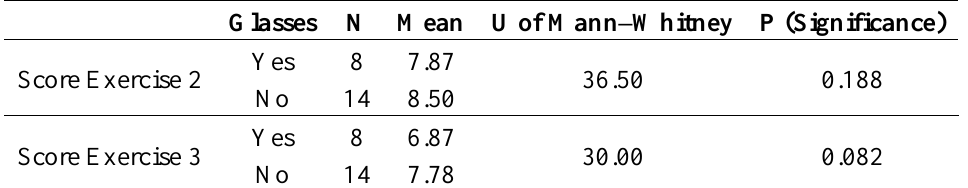
Table 9. Differences in mean scores according to use of